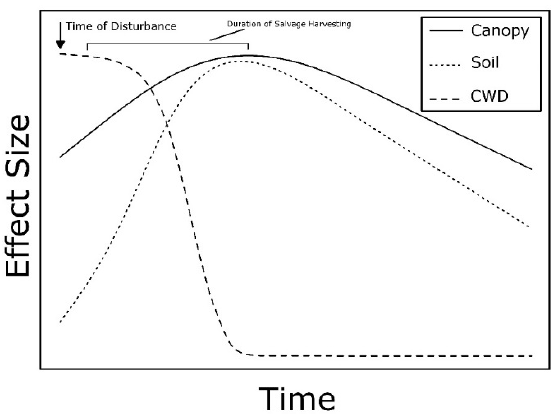
Figure 3. Conceptual model depicting the predicted temporal relationship between the effect sizes of canopy gaps, accumulation and subsequent removal of coarse woody debris (CWD), and soil disruption caused by wind disturbance followed by salvage logging. Time of disturbance denotes the windthrow event and duration of salvage harvesting (indicated by the bar) denotes the length of time of the salvage logging operation.